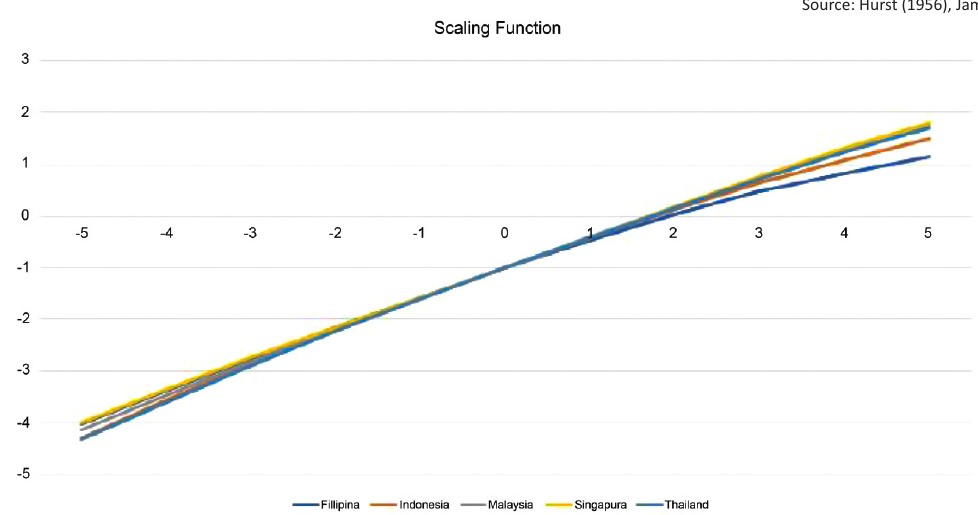
Figure 2. The scaling function of the nonlinear return sequence that shows an existing series of returns is